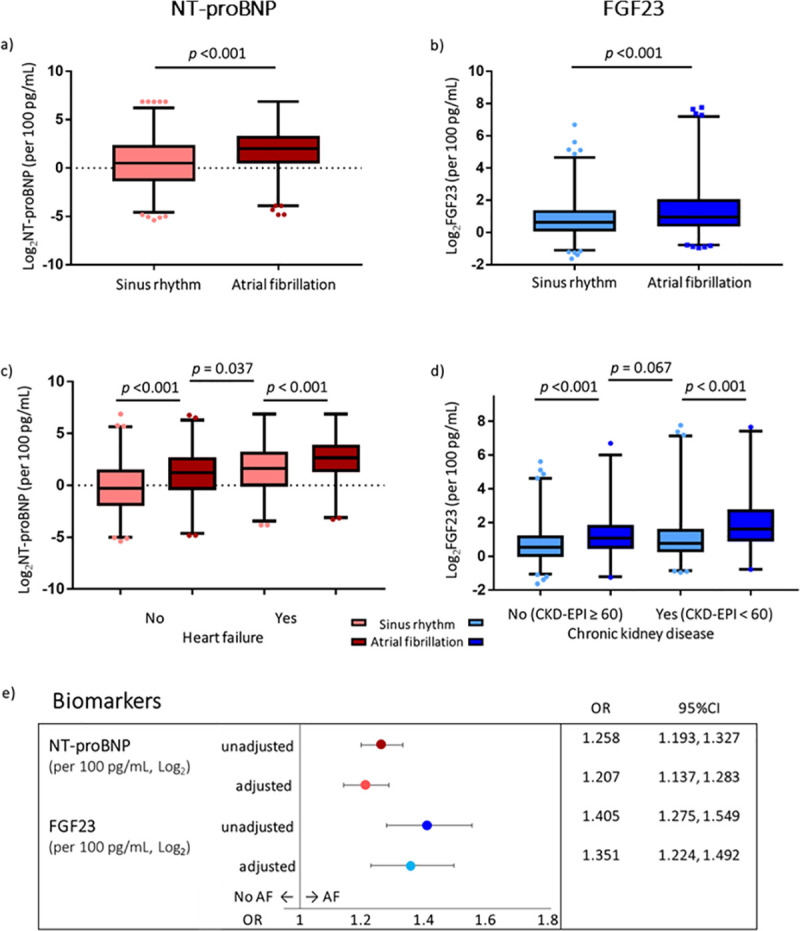
Description of biomarkers.Both (a) NT-proBNP and (b) FGF23 are significantly elevated in patients with AF. Stratified biomarker levels indicate that patients with heart failure and impaired renal function have elevated levels of (c) NT-proBNP and (d) FGF23, respectively. Whiskers represent data between the 1st and 99th percentile, with outliers in dots. (e) Adjusted and unadjusted univariate associations of biomarkers (odds ratios, 95% confidence intervals) show significant associations between NT-proBNP, FGF23, and prevalent AF. NT-proBNP levels were adjusted for age, sex, BMI, and heart failure status. FGF23 levels were adjusted for renal function (estimated glomerular filtration rate [ml/min/1.73 m2] calculated using the CKD-EPI equation). AF, atrial fibrillation; CKD-EPI, Chronic Kidney Disease Epidemiology Collaboration; FGF23, fibroblast growth factor 23; NT-proBNP, N-terminal pro-B-type natriuretic peptide; OR, odds ratio.